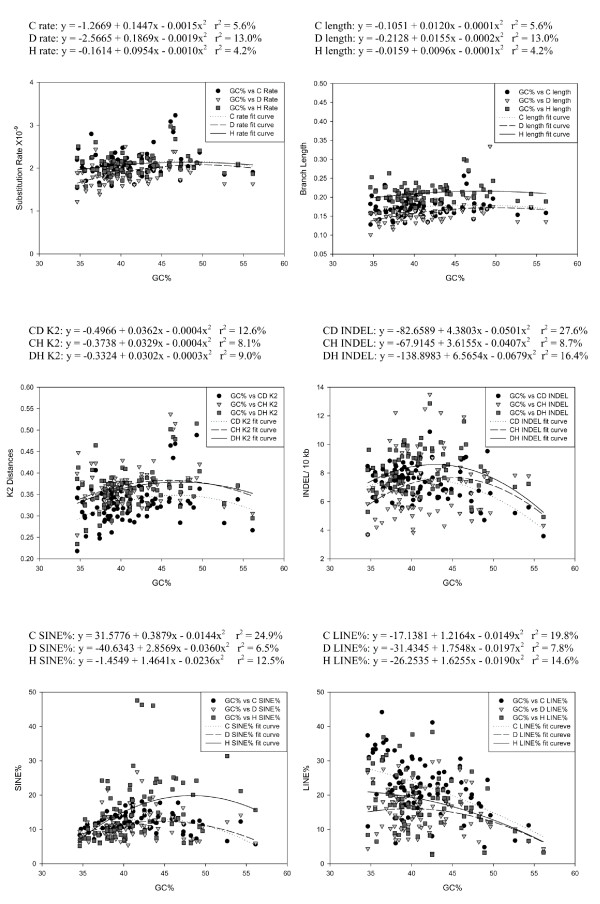
Scatter Plots and Quadratic Fits on Average GC% for Substitution Rate, Branch Length, K2 Distances, INDEL/10 kb, SINE% and LINE%. Scatter plots of substitution rate, branch length, K2 distance, INDEL/10 kb, SINE% and LINE% against average GC% in three-way alignments among cattle (C), dog (D), and human (H). Substitution rates (the top left panel) and branch lengths (the top right panel) were estimated for each species by the PAML package (Methods). For each pairwise comparison in three-way alignments, K2 distances (the middle left panel) and large indel frequency (>100 bp insertion/deletion event count per 10 kb, the middle right panel) were calculated. Other sequence properties in each species such as SINE% (the bottom left panel), LINE% (the bottom right panel) were also plotted. Quadratic fit curves are derived on each plot and their formulas are provided on the top of each panel.